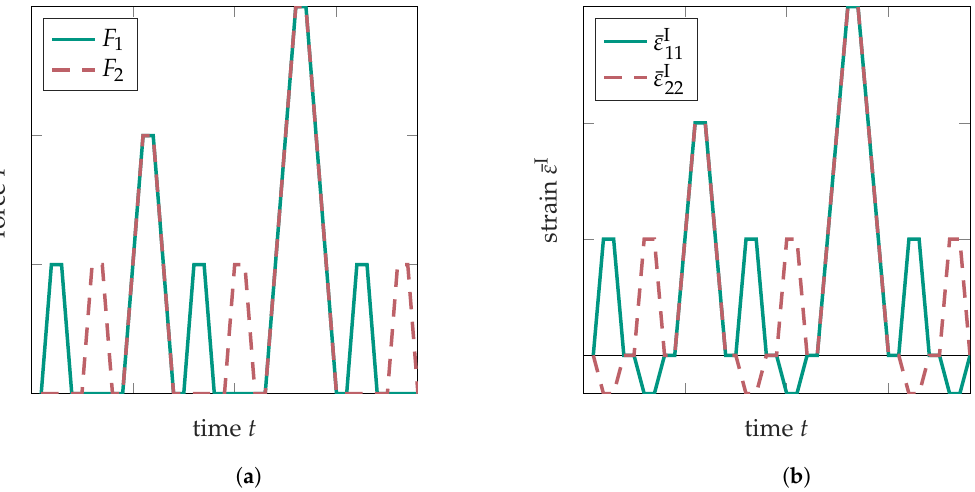
Figure 3. Schematic force and strain paths for experimental procedure P Γ = 1 . ( a ) Force path for procedure P Γ = 1 ; ( b ) Strain path for procedure P Γ = 1